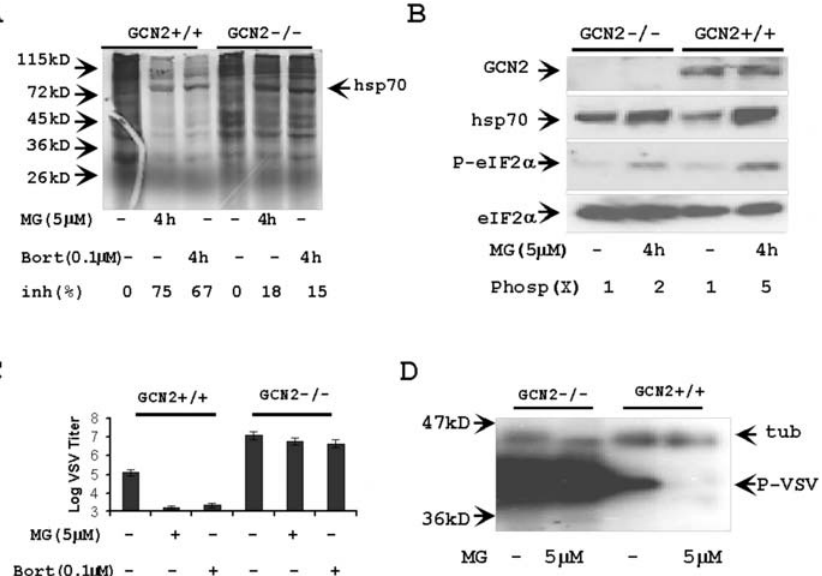
Figure 10. Inhibition of VSV replication in MG132 treated fibroblasts depends on GCN2. (A) Attenuation of translation in MG132- (MG), and Bortezomib (Bort) -treated cells is GCN2-dependent. Control wt GCN2 + / + MEF and GCN2 2 / 2 MEF, or cells treated with proteasome inhibitors for 4 h were incubated with S 35 -methionine/cysteine for 30 min. Protein synthesis was estimated by electrophoresis and autoradiography. (B) Western immunoblotting analysis of GCN2-dependent phosphorylation of eIF2 a in response to MG132. 10 m g of protein extracts from control and MG132 treated cells were analyzed with indicated antibodies. Efficiency’s fold of eIF2 a phosphorylation (Phosp(x)) was estimated with ImageJ software. (C, D) Replication of VSV was not affected by proteasome inhibitors in GCN2 2 / 2 MEF. Proteasome inhibitors were added 1 h after infection with VSV (MOI=1) and cells were incubated over night. Replication of VSV was estimated by titration in two experiments (C), or by Western immunoblotting with anti P-VSV protein Abs (D). Tubulin (tub) is a protein loading control.